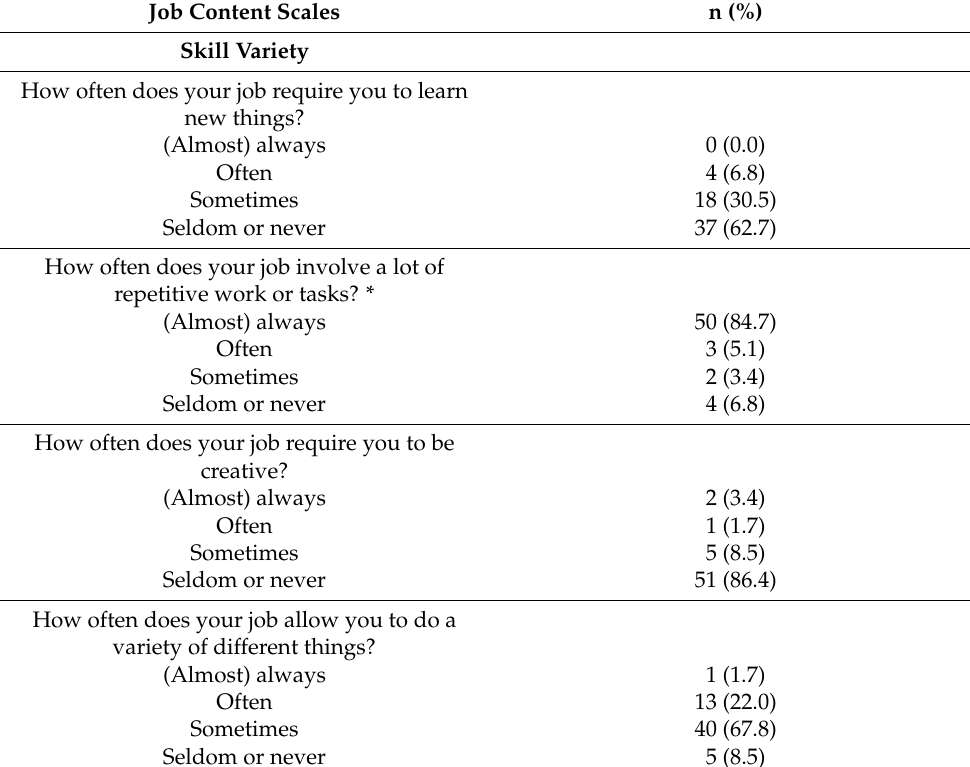
Table 5. Job Content, Latinx Women in Farmworker Families Employed in the Past Year at Follow-Up 5 Questionnaire, North Carolina (N =